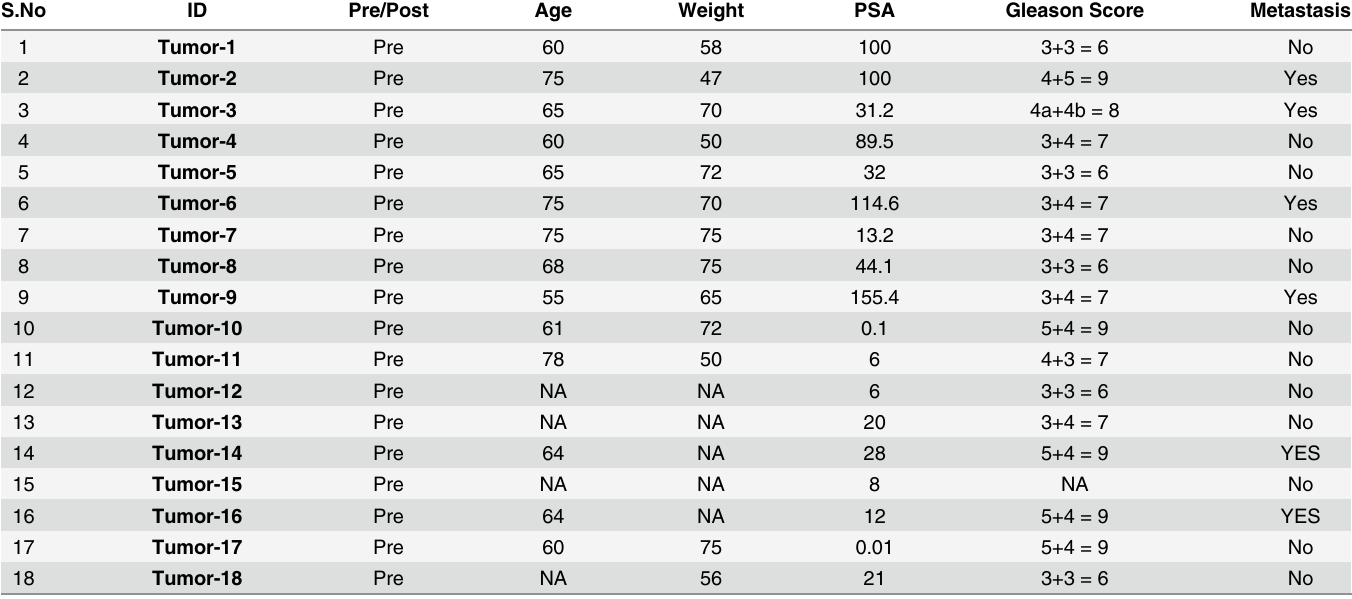
Table 1. List of patients diagnosed with PCa included in the study. The clinical parameters of tumors Gleason score and PSA values are